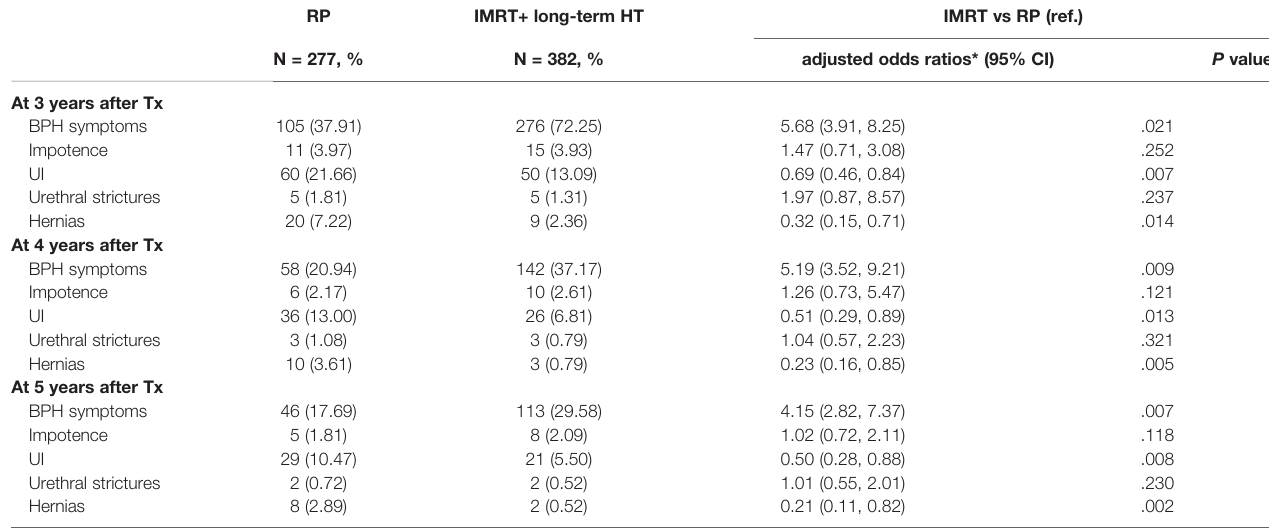
TABLE 2 | Logistic regression analysis of the association of therapeutic modalities with late complications for older men aged ≥ 80 years with high-risk prostate adenocarcinoma.